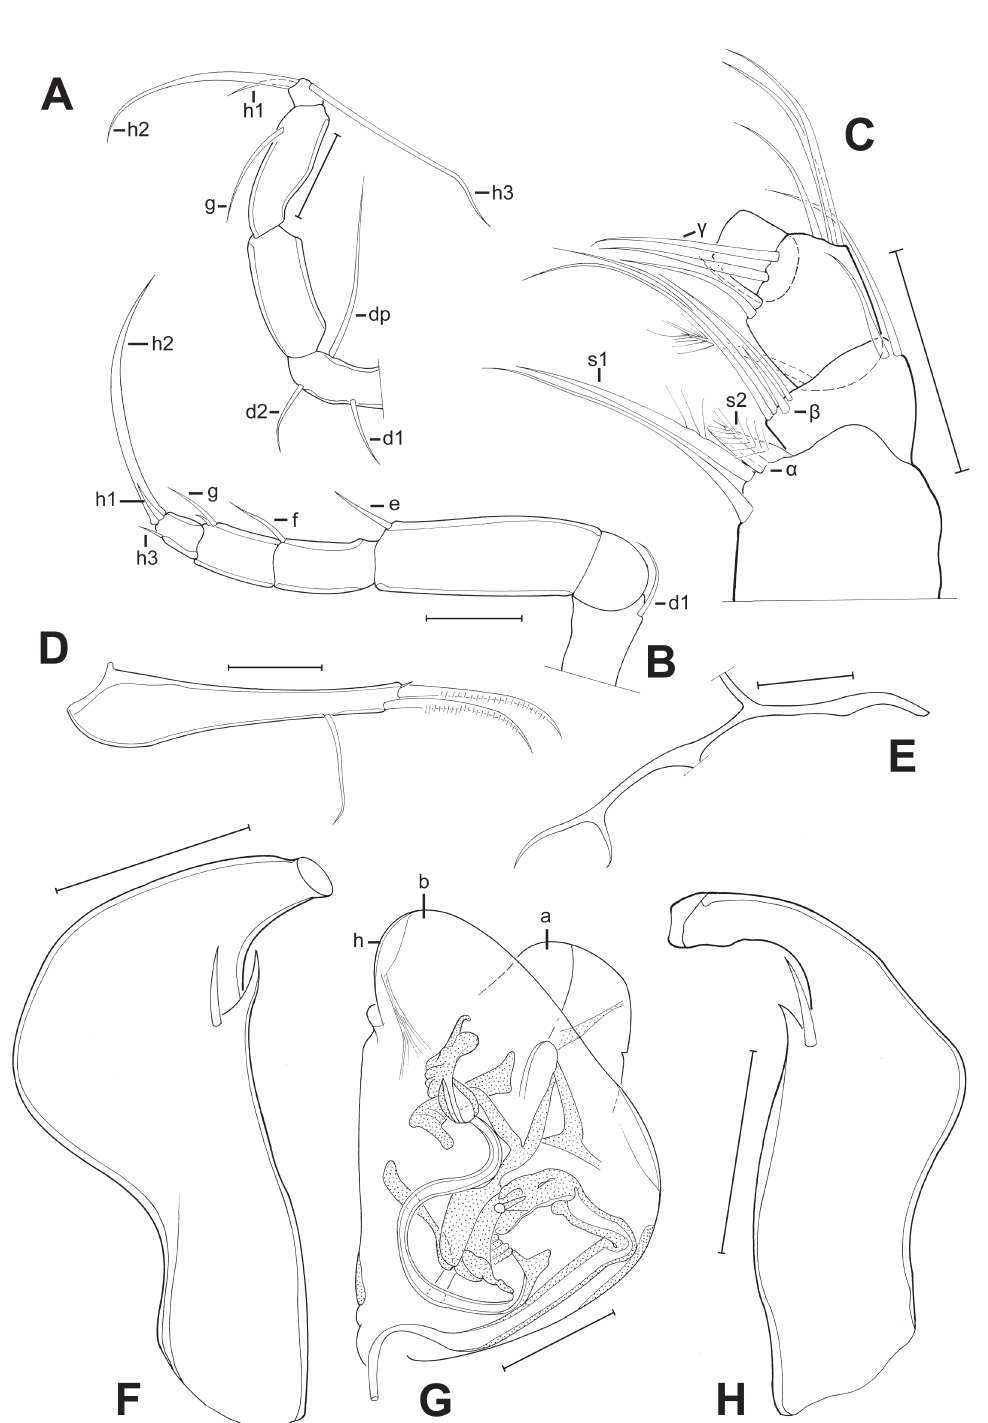
Fig. 7. Limbs of Pseudocandona cillisi sp. nov. (♂). A . T3 (MZUSP 32673). B . T2 (MZUSP 32673). C . Md palp (MZUSP 32673). D . Caudal ramus (MZUSP 32673). E . Attachment of the caudal ramus (MZUSP 32673). F . Left prehensile palp (MZUSP 32673). G . Hemipenis (MZUSP 32673). H . Right prehensile palp (MZUSP 32673). Scale bars: A–H = 50 µ